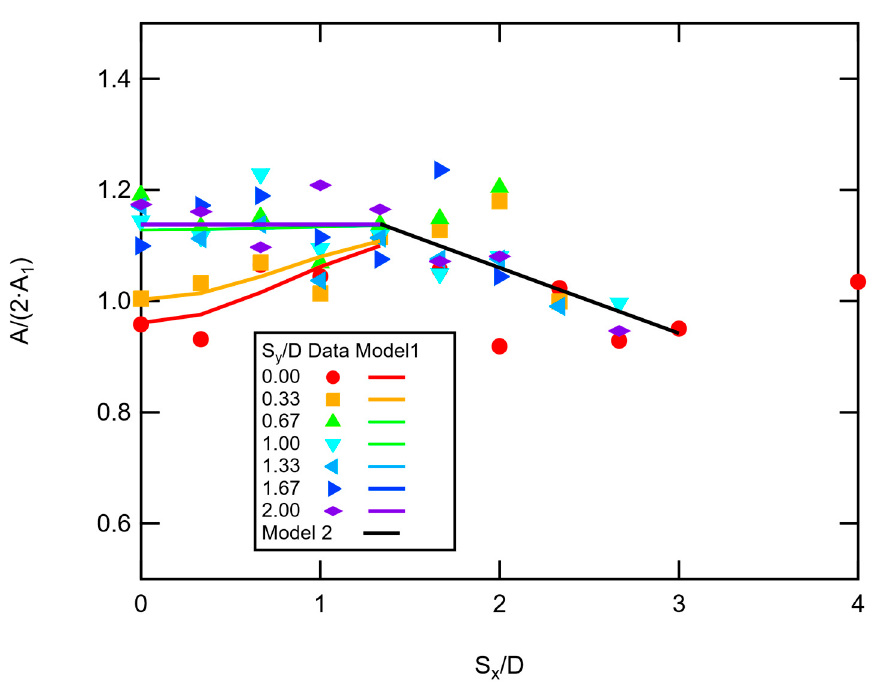
Figure 13. Normalized flame areas for the two-pad experiments in the region where flame merging occurred. Table 6. Curve-fit constants for correlation of two-pad flame area data (Equations (10) and (11)). Constant Value Constant